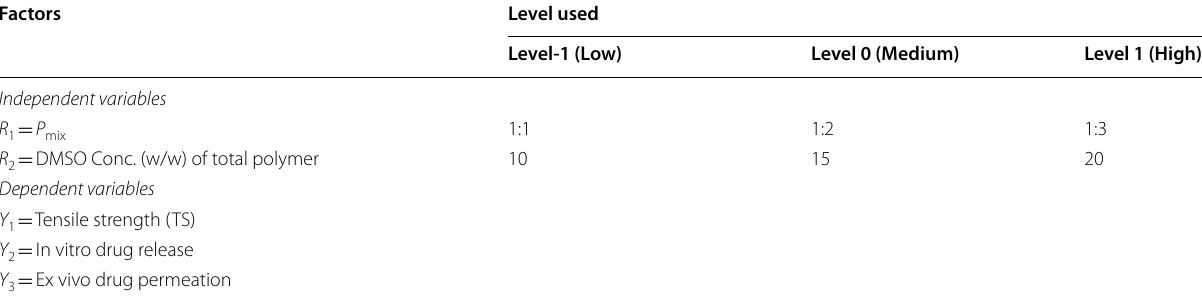
Table 2 Actual unit with coded labels (3 2 factorial designs) Factors